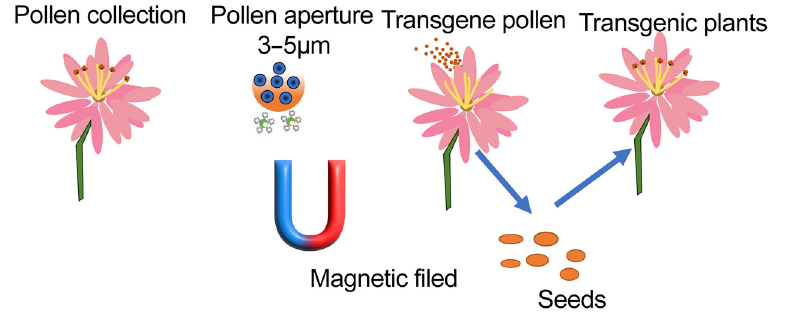
Figure 3. The magnetic nanovectors induce genome engineering with pollens of plants. Plant pollens (about 3–5 µ m) are collected and incubated with nanomaterial–DNA complexes in a magnetic field. Then, the transgene DNA-containing pollens are sprayed onto the surface of pistil stigma to obtain the transgenic seeds.